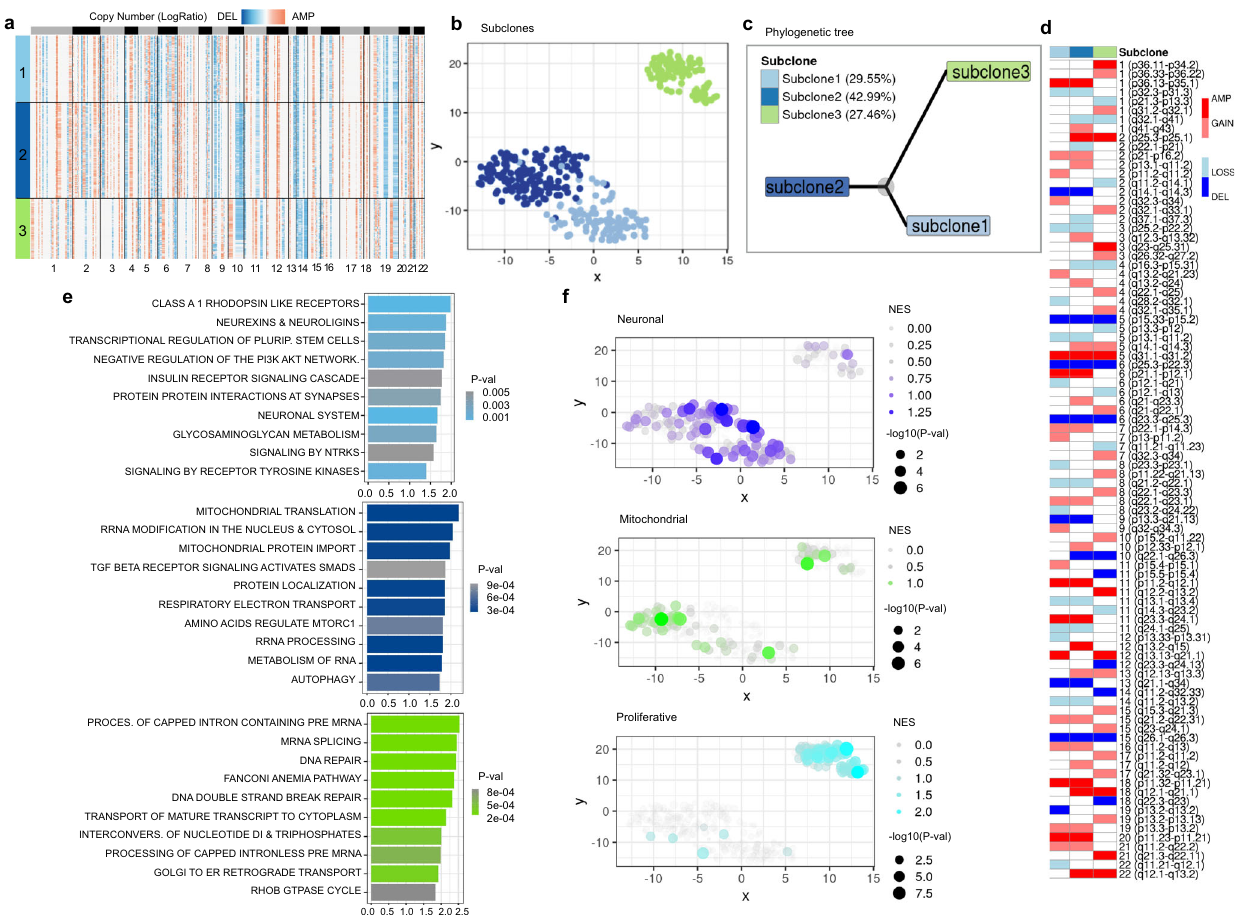
Fig. 4 | Deconvolution of the clonal substructure. a Clonal structure of sample BT1160 inferred by SCEVAN. b t-SNE plot of CNA matrix. c Inferred phylogenetic tree. d OncoPrint-likeplotof BT1160highlighting clone-speci fi calterations,shared alterationsbetween,andclonalalterations. e GSEAwasperformedonREACTOME 36 pathwaysforeachsubclonewithaminimumsizeof15genesandamaximumsizeof 500 genes and with 10,000 as the number of permutations using the